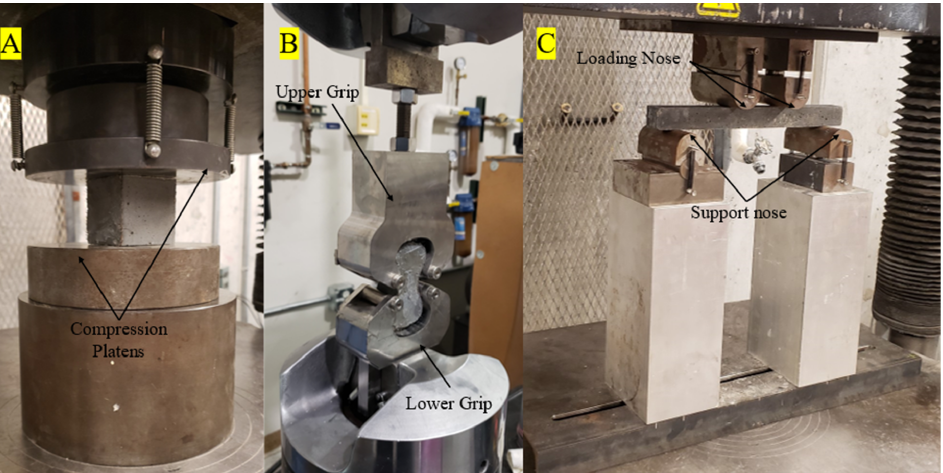
Figure 3. The three different test methods being performed. ( A ) compression cube; ( B ) tensile test; ( C ) flexural test with a 229 mm major span and a 76 mm minor span.